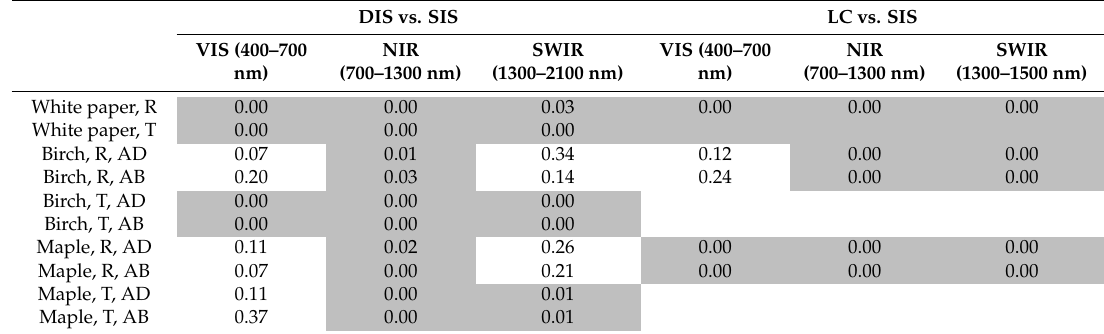
Table B2. Mean p -values in Welch’s t -test comparing differences in mean spectra between measurement methods. The value for each wavelength region (VIS, NIR, SWIR) is the mean of individual p -values of all 1 nm bands belonging to the region. Statistically significant regions ( p < 0.05) are highlighted. R = reflectance, T = transmittance, AD = adaxial side, AB = abaxial side.